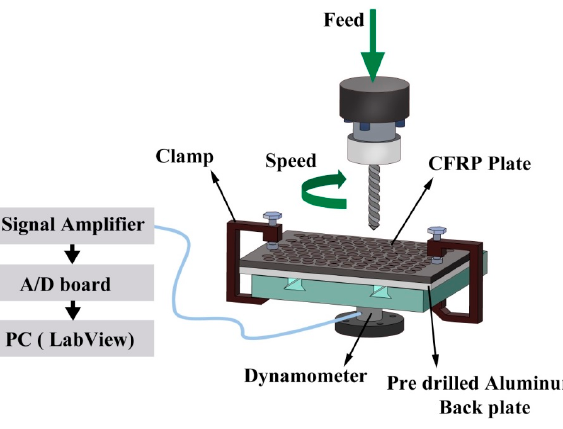
Figure 3. Schematic of the dry-drilling experimental set up.